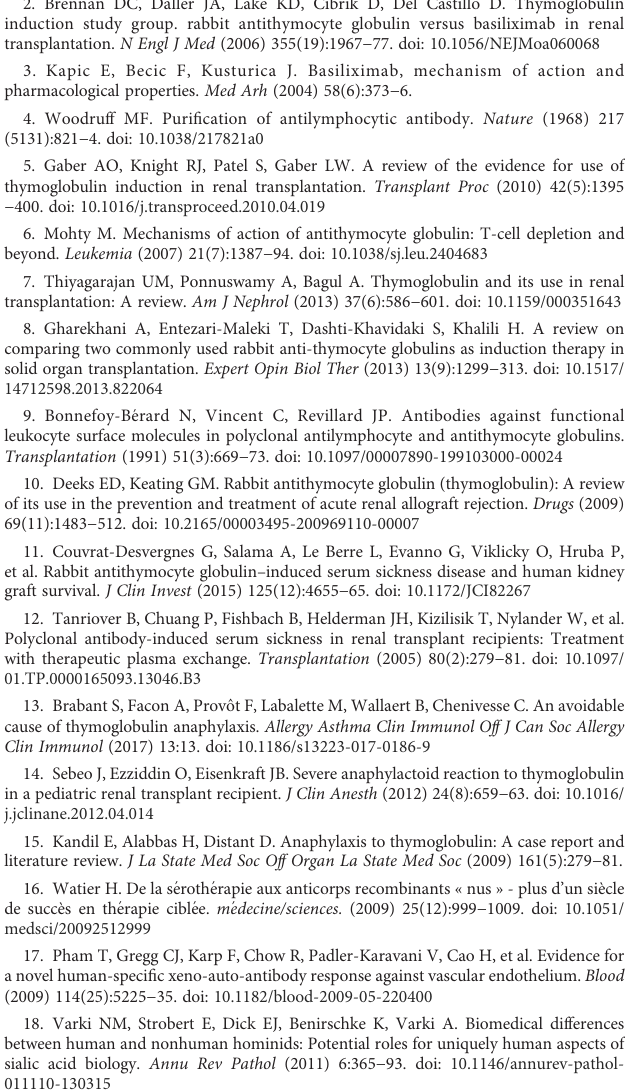
50ug/mL. After saturation and washing, revelation is performed with Alexa Fluor 488 conjugated protein G diluted at 1/200 or 1/400 and the reading performed in fl uorescence with TECAN. (B): Analysis of binding kinetics by BLItz (bio-layer interferometry) of GH-ALG and rabbit-ATG on G protein. Supplemental Figure 2 Evaluation of the GH-ALG active fraction. One milliliter of GH-ALG diluted in PBS to a concentration of 1.6 mg/mL was incubated with 30.10 6 targetlymphocytecells. After20minofincubation atroomtemperature, the supernatant (SN1) was transferred to a second tube containing 30.10 6 target T lymphocytes. After 20 min of incubation at room temperature, the supernatant (SN2) was collected and stored until SN5. The supernatants obtained were serially diluted and then incubated (30 min, 4°C) with fresh XT1501 cells. After washing, a secondary anti-pig antibody was deposited, revealing the remaining XT1501-speci fi c antibody fraction. GH-ALG was used as a positive speci fi city control. Nonimmune IgGs were used as a negative